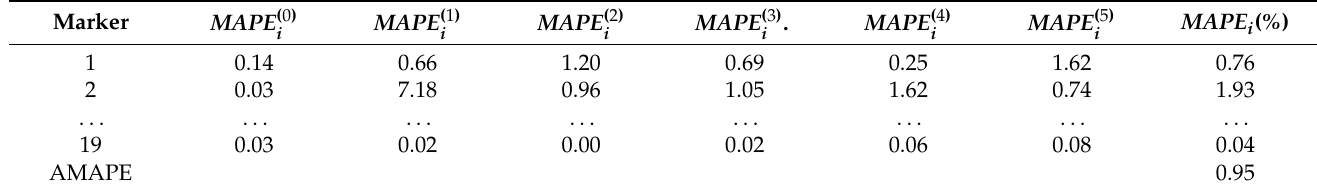
Table 10. Error of reconstruction stage.